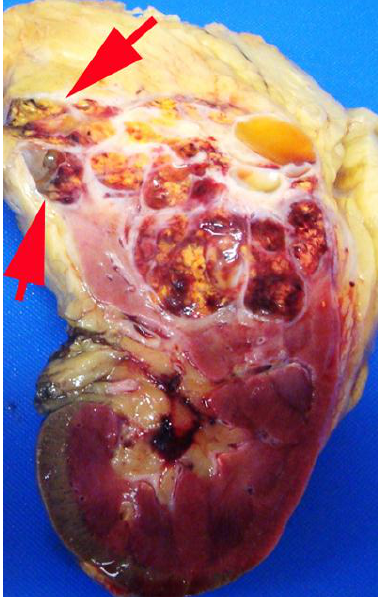
Figure 3 B. When RCC invades through the renal capsule into the perinephric fat, there is loss of the smooth convex outer contour, with nodules or irregular tumor masses protruding into the perinephric fat.